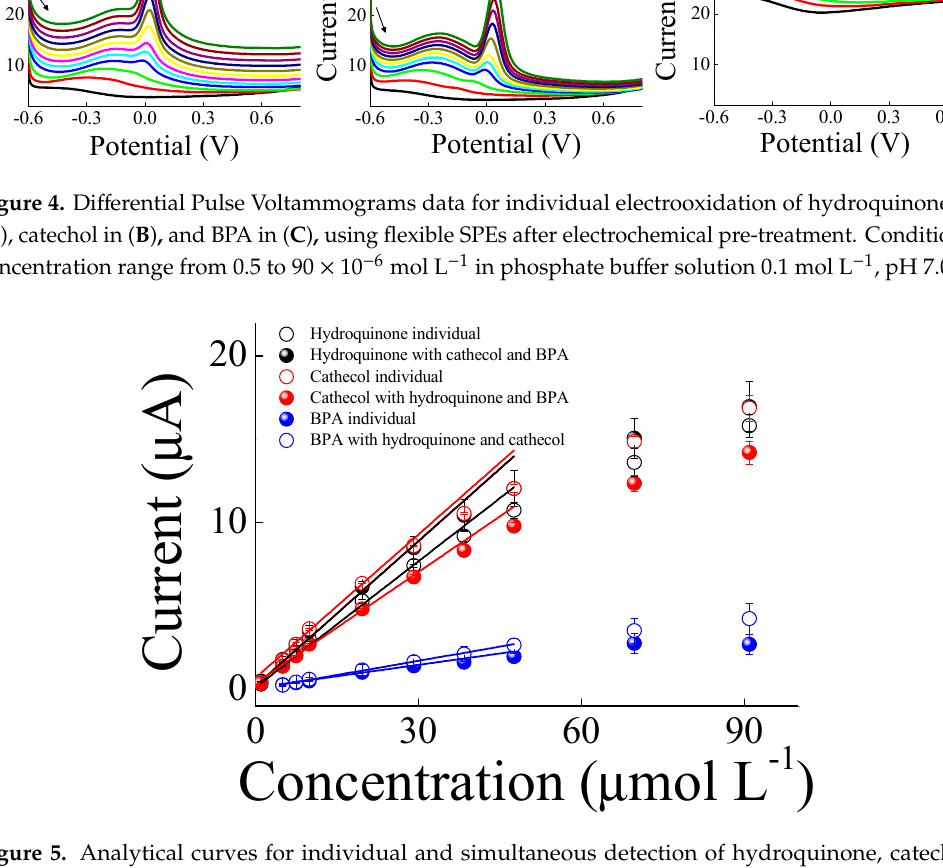
Figure 5. Analytical curves for individual and simultaneous detection of hydroquinone, catechol, and BPA. Conditions: concentration range from 2.0 to 90 × 10 − 6 mol L − 1 in phosphate buffer solution 0.1 mol L − 1 , pH 7.0.